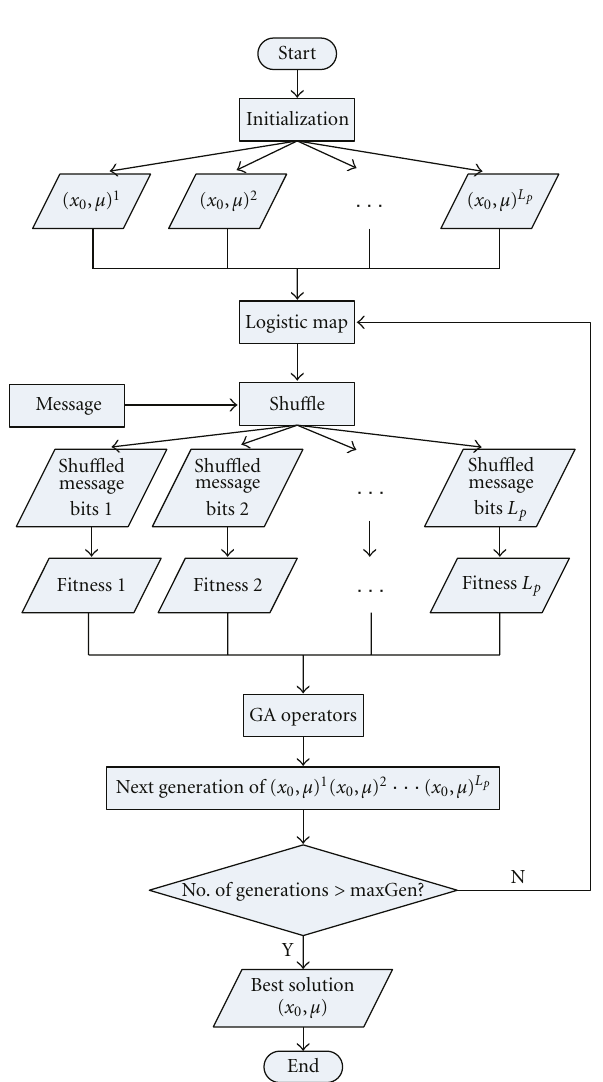
Figure 2: Process of using GA to find the best pair input for logistic map.